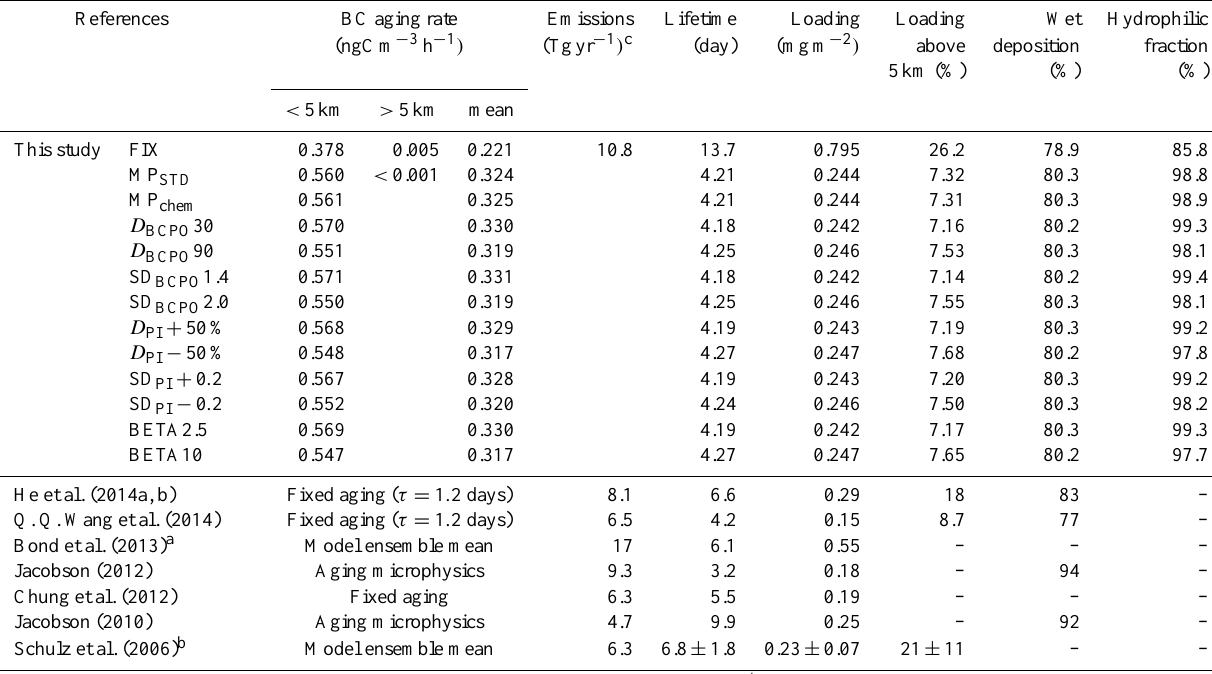
Table 2. GEOS-Chem simulated global annual mean BC budget.